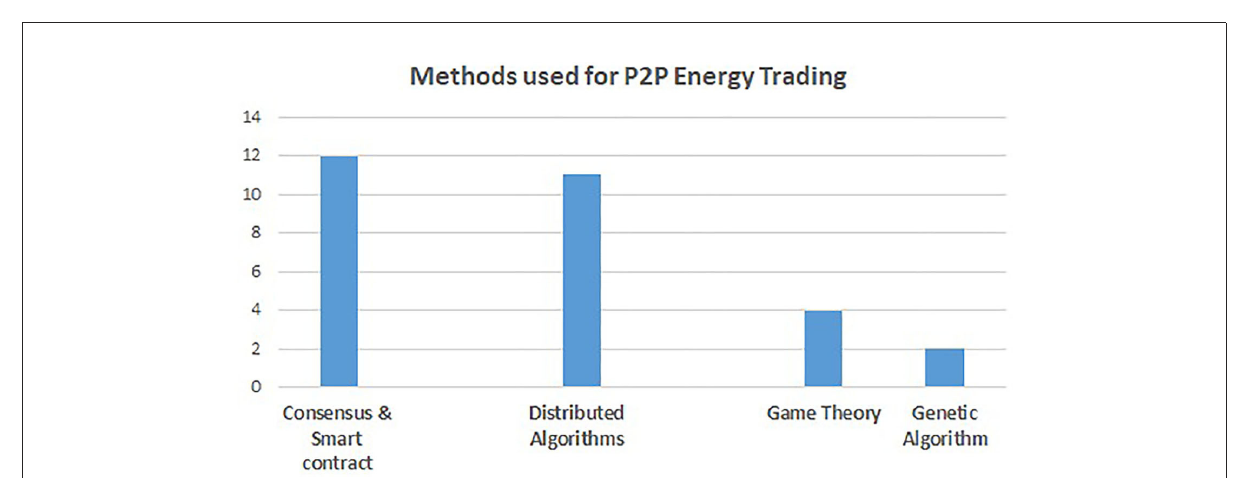
FIGURE15 Distribution of methods used for P2P energy trading